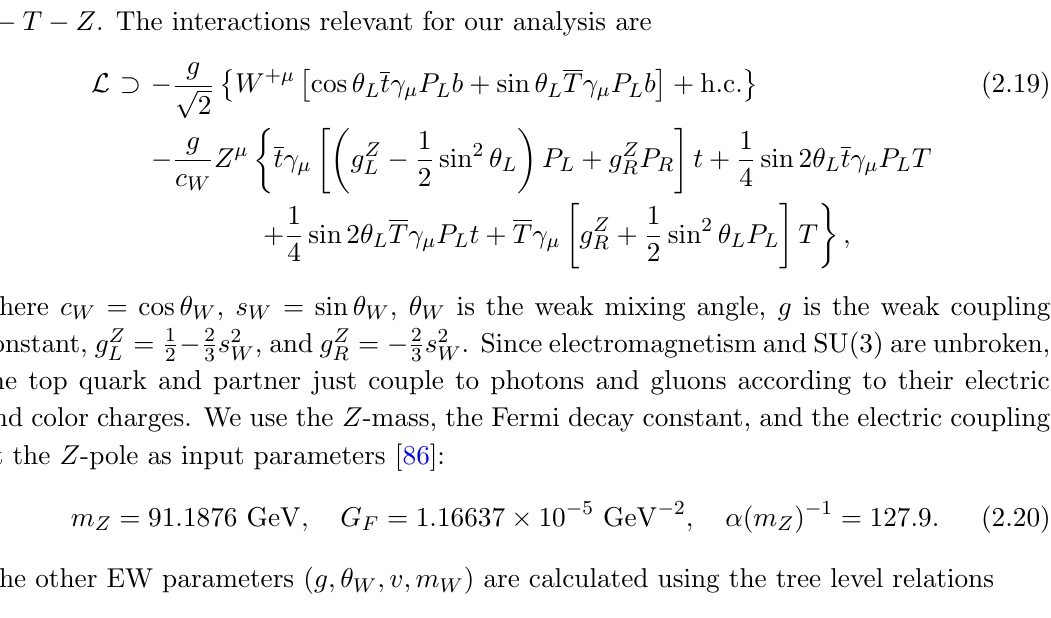
Figure 1 . Top partner decay diagrams in the limit that v Counterterms and external (cid:13)avor changing self-energies are not